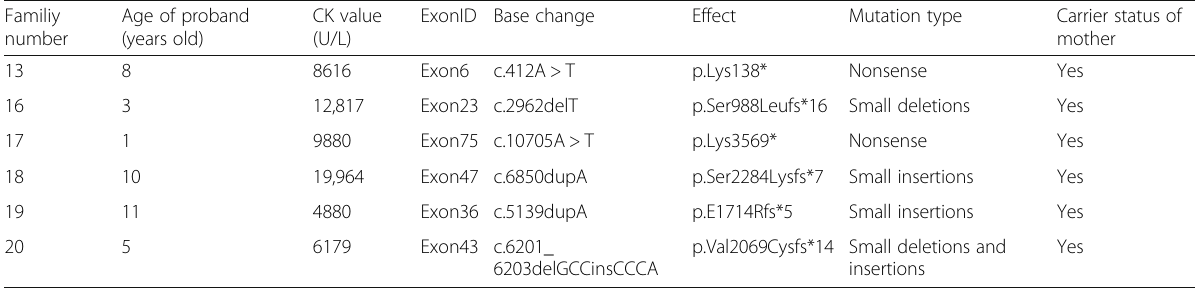
Table 2 The novel mutations diagnosed by NGS